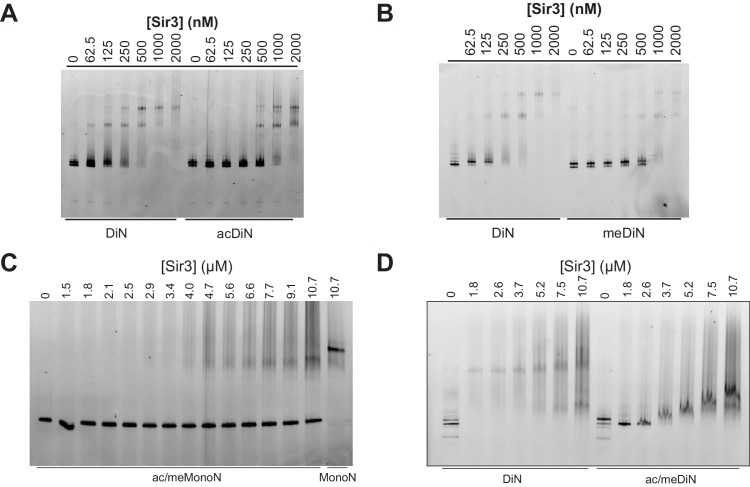
Sir3 binding to singly and doubly modified H4K16 acetylated and H3K79 methylated MonoN and DiN.(A) EMSA experiments comparing Sir3 binding to the unmodified and H4K16ac DiN. (B) EMSA experiments comparing Sir3 binding to unmodified and H3KC79me3 DiN. We note that Sir3 bound H4K16ac and H3KC79me3 MonoN and DiN (Figure 5A–B) shift to a lower position than Sir3 bound unmodified nucleosomes, suggesting that Sir3 binds to modified nucleosomes in a different conformation than to unmodified nucleosomes. (C) EMSA experiments showing Sir3 binding to doubly modified H4K16ac/H3KC79me3 MonoN. There was about 10% MonoN shift at 10.7 μM Sir3. (D) EMSA experiments showing Sir3 binding to unmodified and doubly modified H4K16ac/H3KC79me3 DiN.